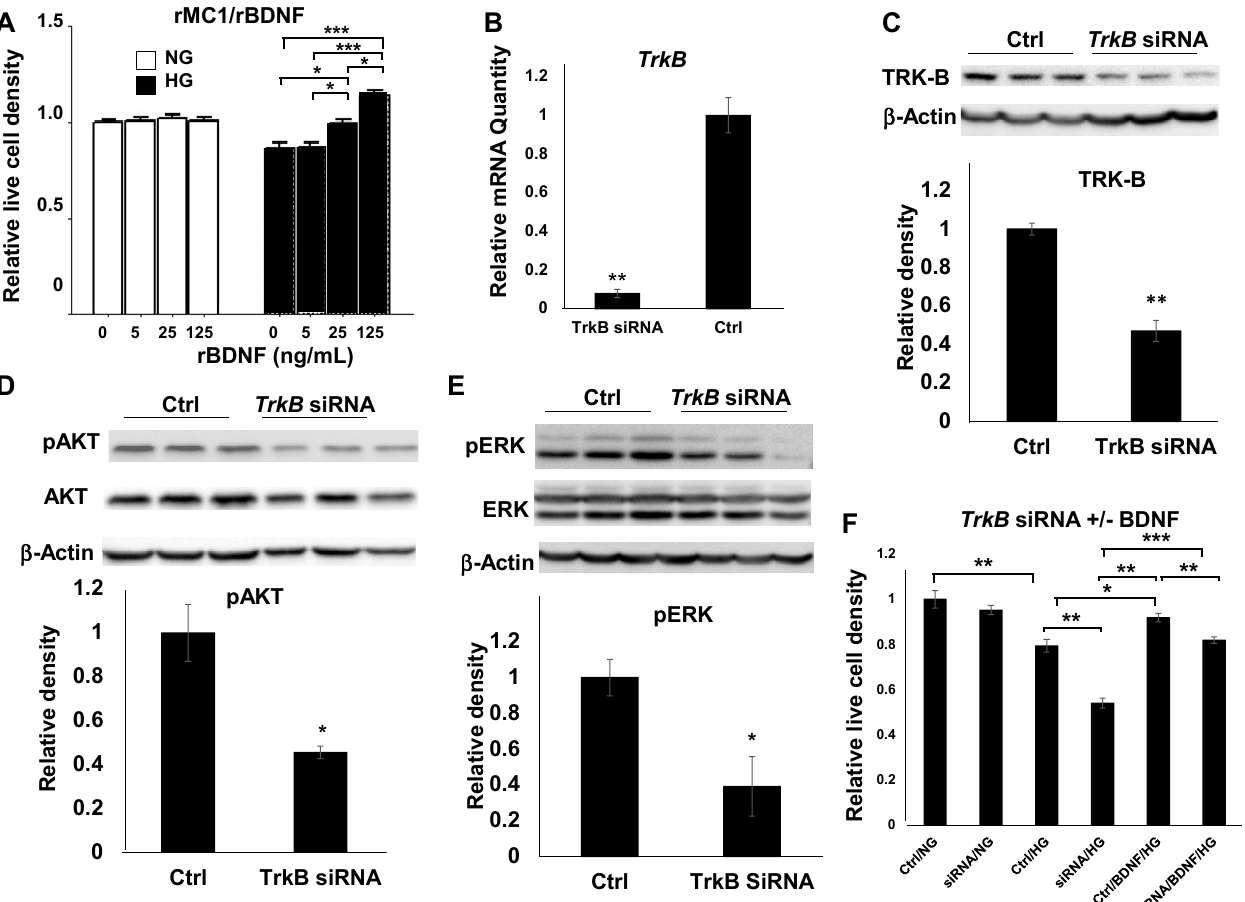
Figure 3. BDNF-mediated MC viability. ( A ) Viability of rMC1 cells cultured in NG or HG media with or without rBDNF. A : rBDNF-mediated rMC1 cell viability in a dose-dependent manner under a diabetes-like condition. ( B , C ) Quantitative RT-PCR and immunoblotting analysis of rMC1 cells 48 h after TrkB siRNA and scramble siRNA control (Ctrl) transfection. ( D , E ) Analysis and representative images of immunoblotting for pAKT and tAKT ( D ) and pERK and tERK ( E ) in rMC1 cells transfected with TrkB siRNA and scramble control siRNA 48 h post-transfection in HG media. ( F ) rBDNF (25 ng/mL) rescued HG-induced loss of rMC1 cells transfected with TrkB siRNA and scramble control siRNA. Graph bars represent mean ± SEM. *: p < 0.05; **: p < 0.01; ***: p < 0.001. TrkB knockdown significantly reduced its mRNA and protein levels and MC viability under diabetic conditions.